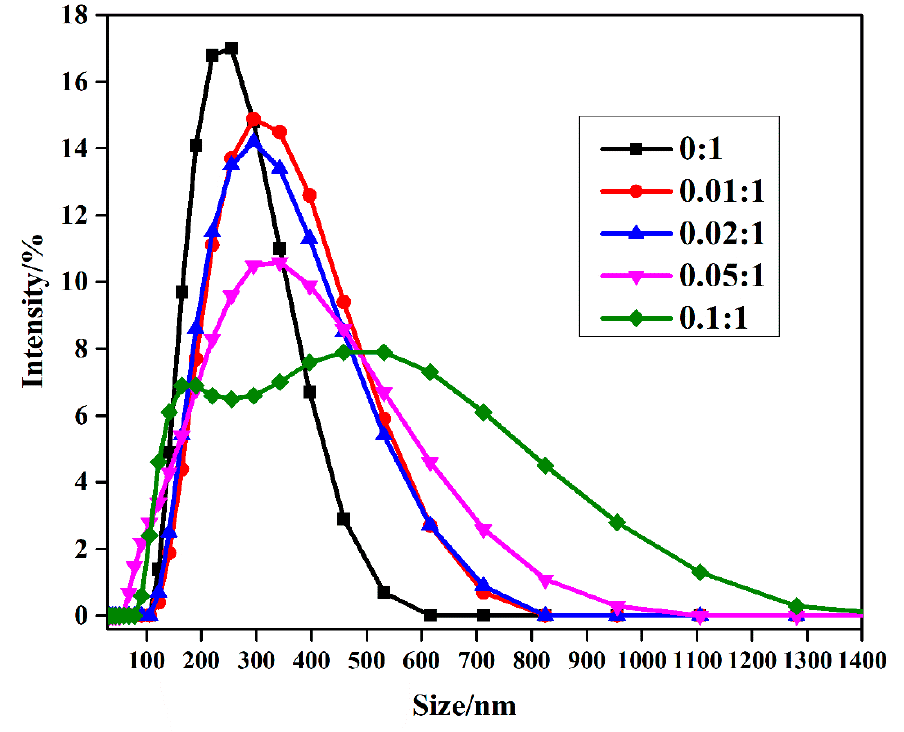
Figure 2. Size distributions of drug-loaded MPEG-PDLLA/c-MWCNT nanocomposites prepared from different amounts of c-MWCNTs added to the MPEG-PDLLA/c-MWCNTs mixed solutions (determined by dynamic light scattering (DLS) at 25 °C).